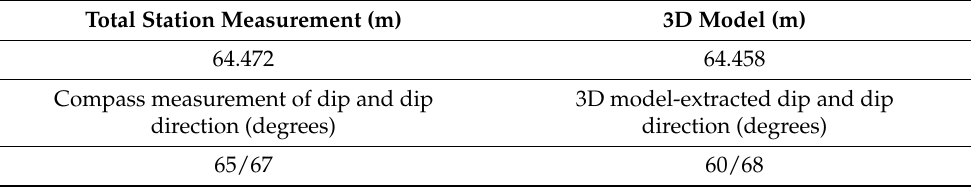
Table 1. Independent check measurements.